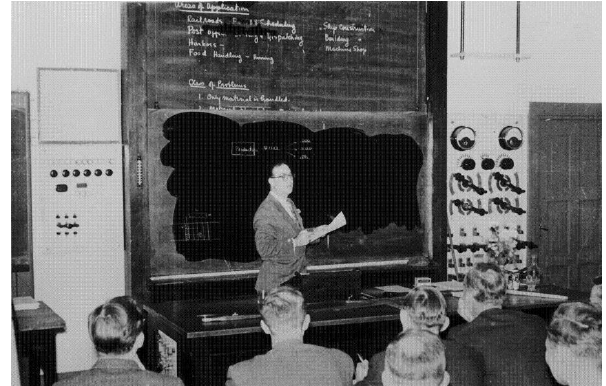
Figure 2: Professor Donald P. Campbell teaches servo engineering in Norway during the summer of 1956. The course had 60 participants.